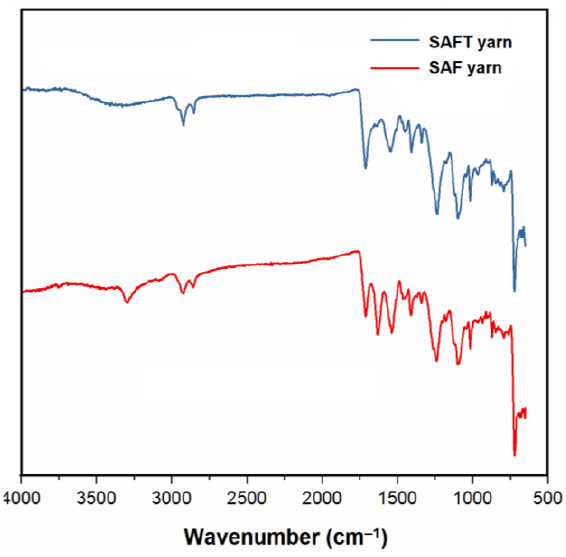
Figure 2. FT-IR spectra of SAF yarn and SAFT yarn. Figure 2 . FT-IR spectra of SAF yarn and SAFT yarn.